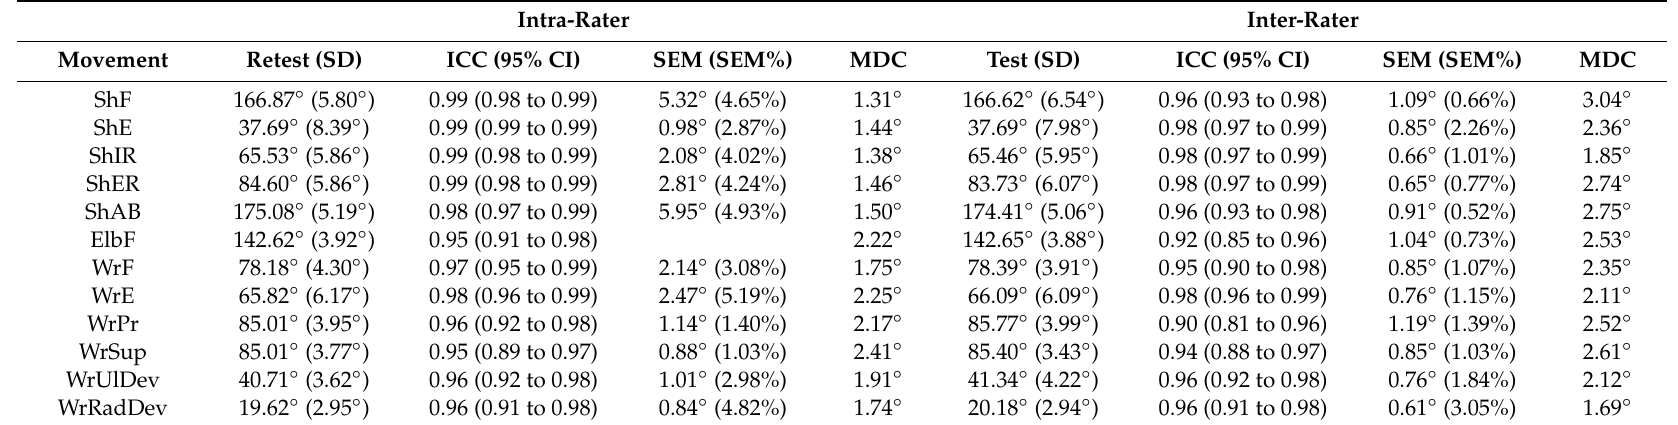
Table 3. Reliability of Veloflex-IDA to measure the range of motion of the upper limb joints in symptomatic participants. Intra-Rater